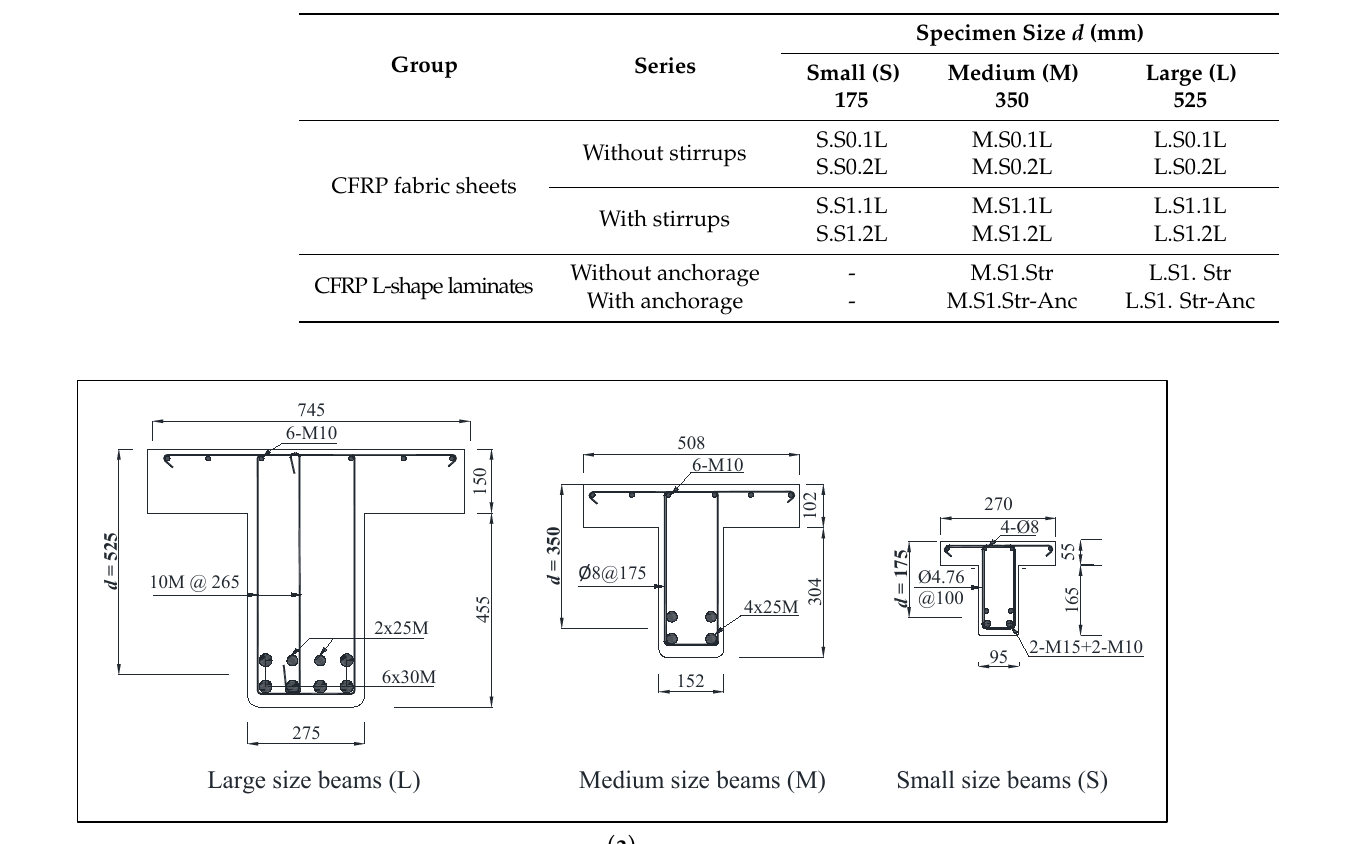
Table 2. Experimental program matrix.